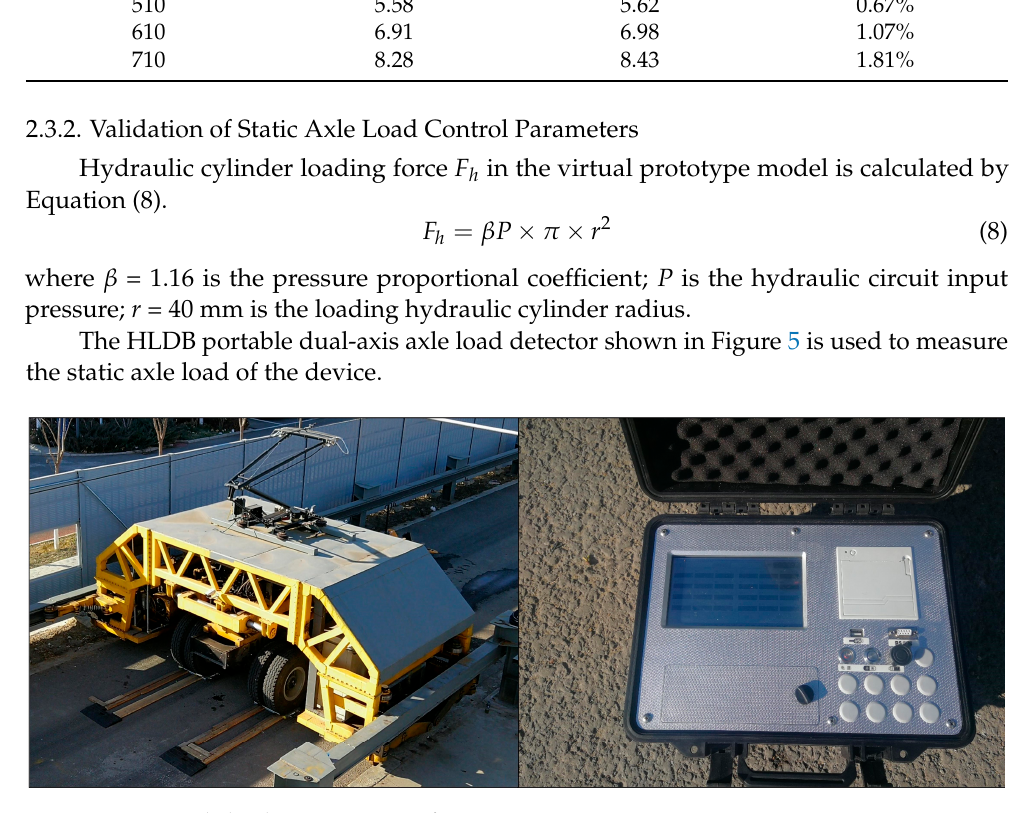
Figure 5. Static axle load measurement of NE-ALT.